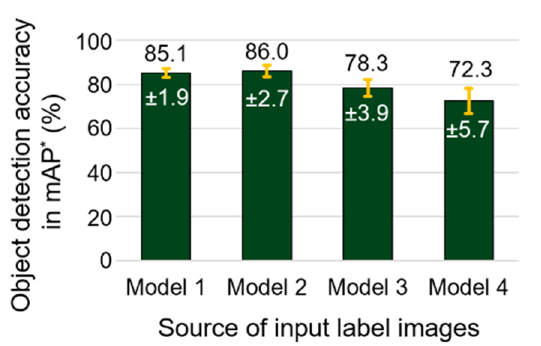
Figure 8. Average and standard deviation of object detection accuracy of randomly chosen training and testing data, generated from input data of Models 1–4 in Table 2. * mAP: mean average precision (mAP) when intersect over union (IoU) is greater than 50%.